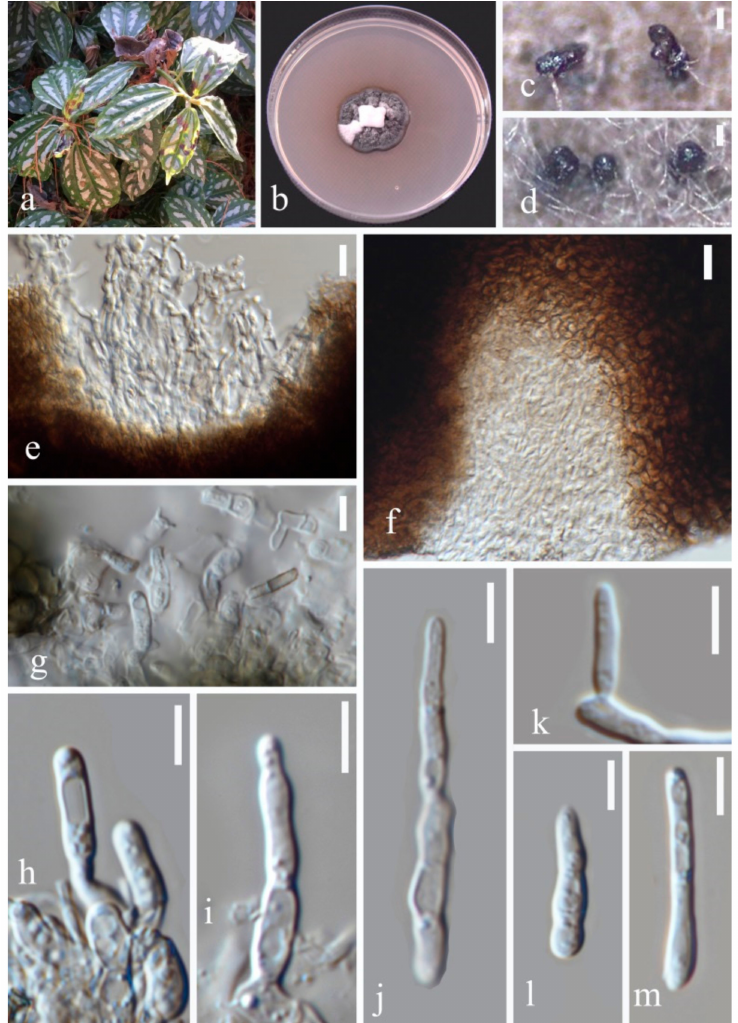
Figure 4. Septoria pileicola (GUCC 2131.4): ( a ) Leaf spot symptoms on the host. ( b ) Colonies on PDA culture. ( c,d ) Conidiomata on PDA culture. ( e,f ) Section though conidioma. ( g – k ) Conidiogenous cells. ( l,m ) conidia. Scale bars: ( c , d ) = 125 µ m, ( e – g ) = 10 µ m, ( h – m ) = 10 µ